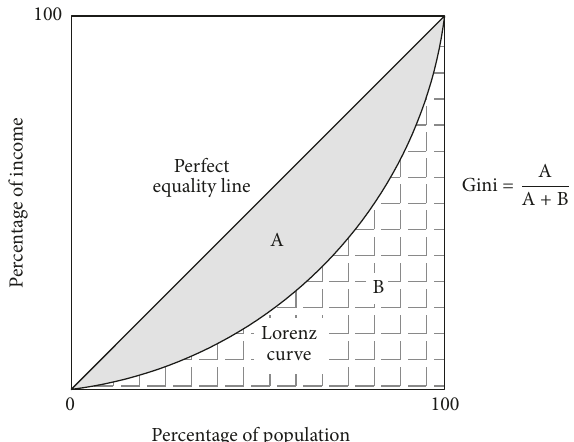
Figure 2: Lorenz curve and Gini